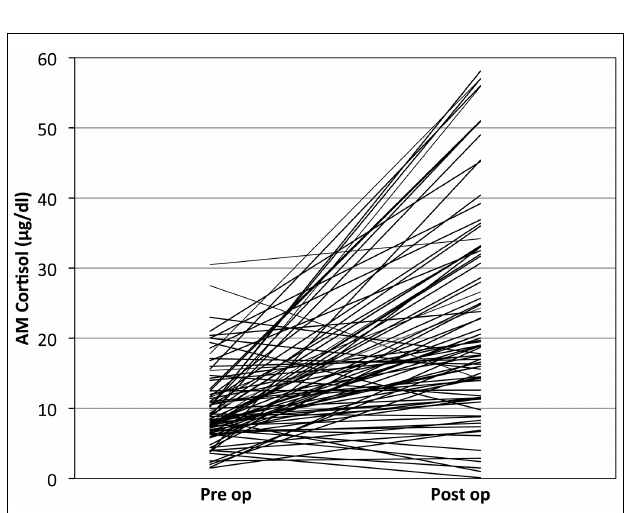
FIGURE 3 | Individual patient’s cortisol response to pituitary surgery: note that most, but not all patients operated without stress steroids show a significant rise in cortisol over